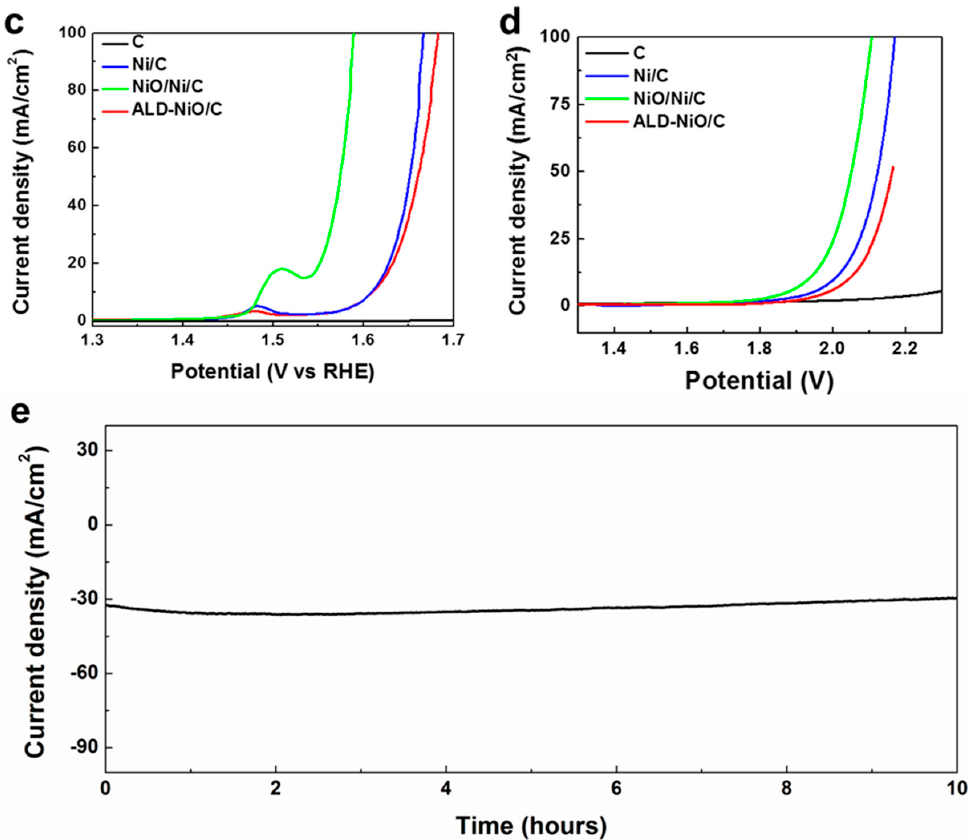
Figure 4. Electrocatalytic activity of ALD-NiO/C, Ni/C and NiO/Ni/C samples for water splitting in 1 M KOH; ( a ) cathodic polarization curves; ( b ) the corresponding hydrogen evolution reaction (HER) Tafel plot; ( c ) oxygen evolution reaction (OER) activity; ( d ) polarization curves for NiO/Ni/C||NiO/Ni/C, Ni/C||Ni/C, ALD-NiO/C||ALD-NiO/C, and C||C in a two-electro setup for overall water splitting; ( e ) the stability of NiO/Ni nanoparticles loaded on carbon fiber paper. All Linear Sweep Voltammetry (LSV) curves are iR corrected. iR represents internal resistance in different solutions, it is a parameter.